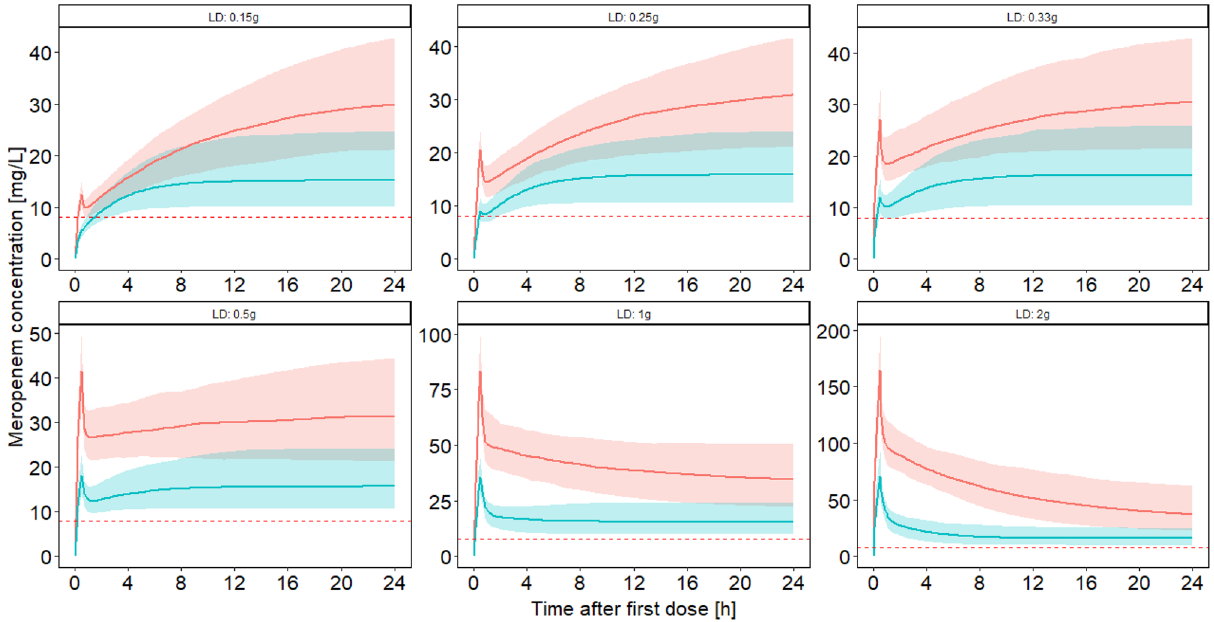
Figure 3. Predicted plasma concentration–time profile in a best- and worst-case scenario with six different loading doses. in the worst case scenario (blue line = median concentration, blue area = 90% prediction interval) the profile of a patient with a creatinine clearance according to Cockcroft and Gault 9 of 160 mL/min, albumin concentration of 1 g/dL and body weight of 150 kg (maintenance dose: 6 g/24 h) was simulated. In the best- case scenario (red line = median concentration, red area = 90% prediction interval) the profile of a patient with to 12 . LD: loading